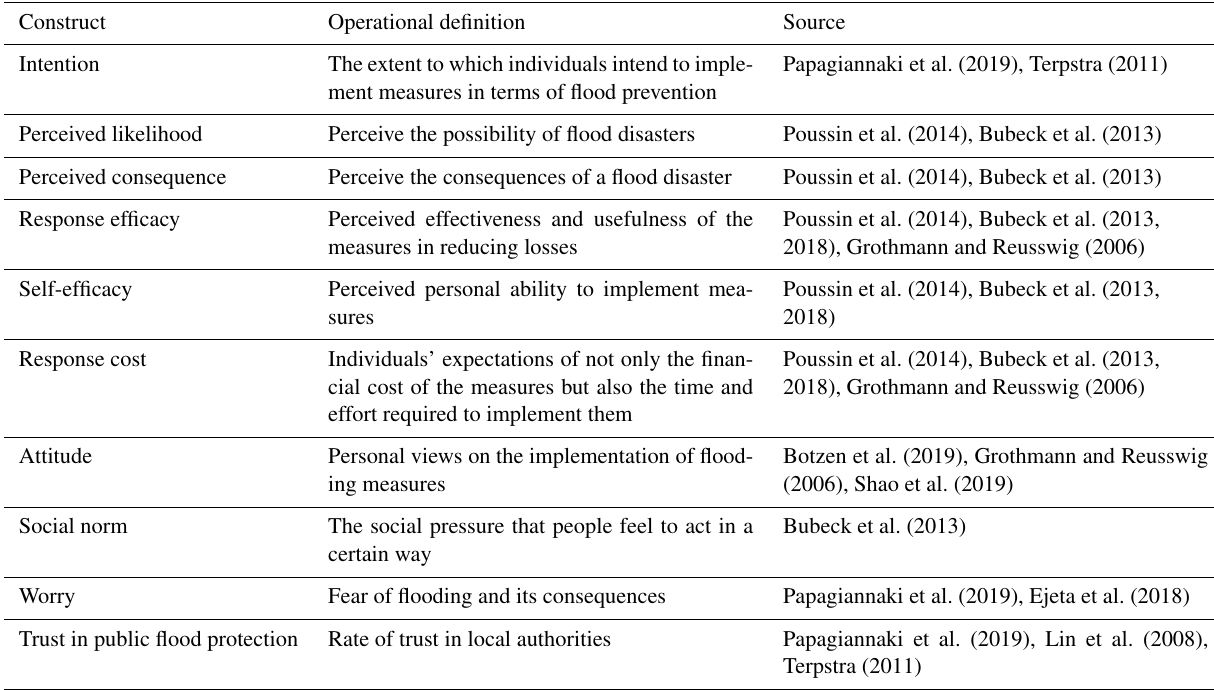
Table 1. Operational definitions and sources for